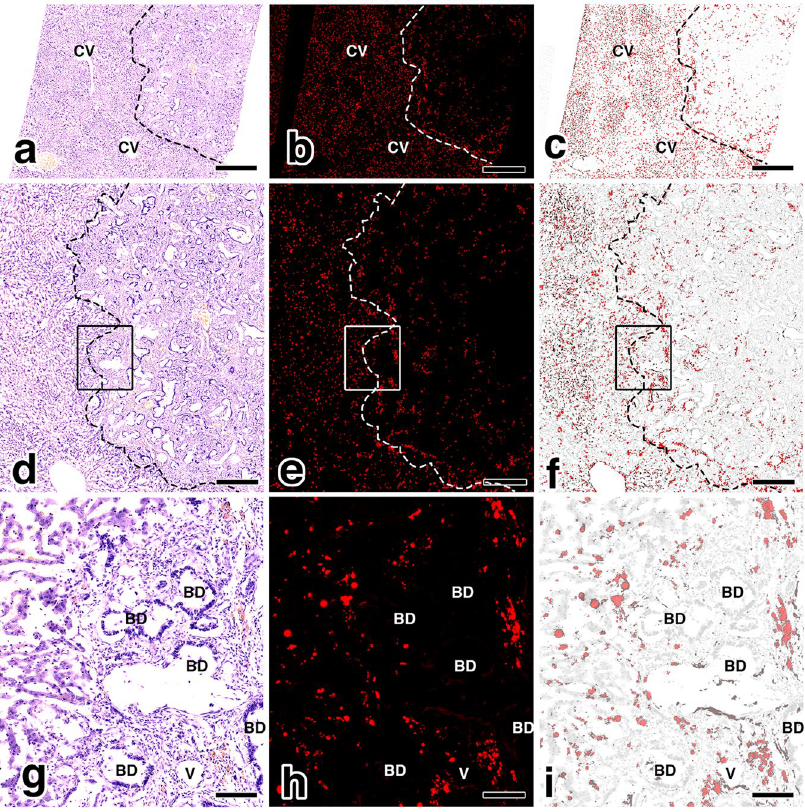
Figure 5. Histological FI of the pathological liver of the LEC rat. The HE section demonstrated liver lobules containing cellular plates were directed from the periphery of the liver lobules to the central veins (CV) on the left side of the slide at lower magnification ( a ). On the right side, there was hyperplasia of the ductules surrounded by fibrous tissue, indicating cholangiofibrosis ( a , d and g ). There were a larger number of labeled cells in the normal area on the left side than in the cholangiofibrosis area on the right side ( b ). The merged findings revealed that the cholangiofibrosis area did not contain as many labeled cells as the normal area ( c , f and i ). At higher magnification of the areas marked with rectangles ( d – f ), some labeled cells were detected in the cholangiofibrosis area (g – i ). The labeled cells were located near the vessels (V) but not near the bile ducts (BD) ( f and i ). Scale bars: ( a – c ) 1 mm, ( d – f ) 0.5 mm, ( g – i ) 0.1